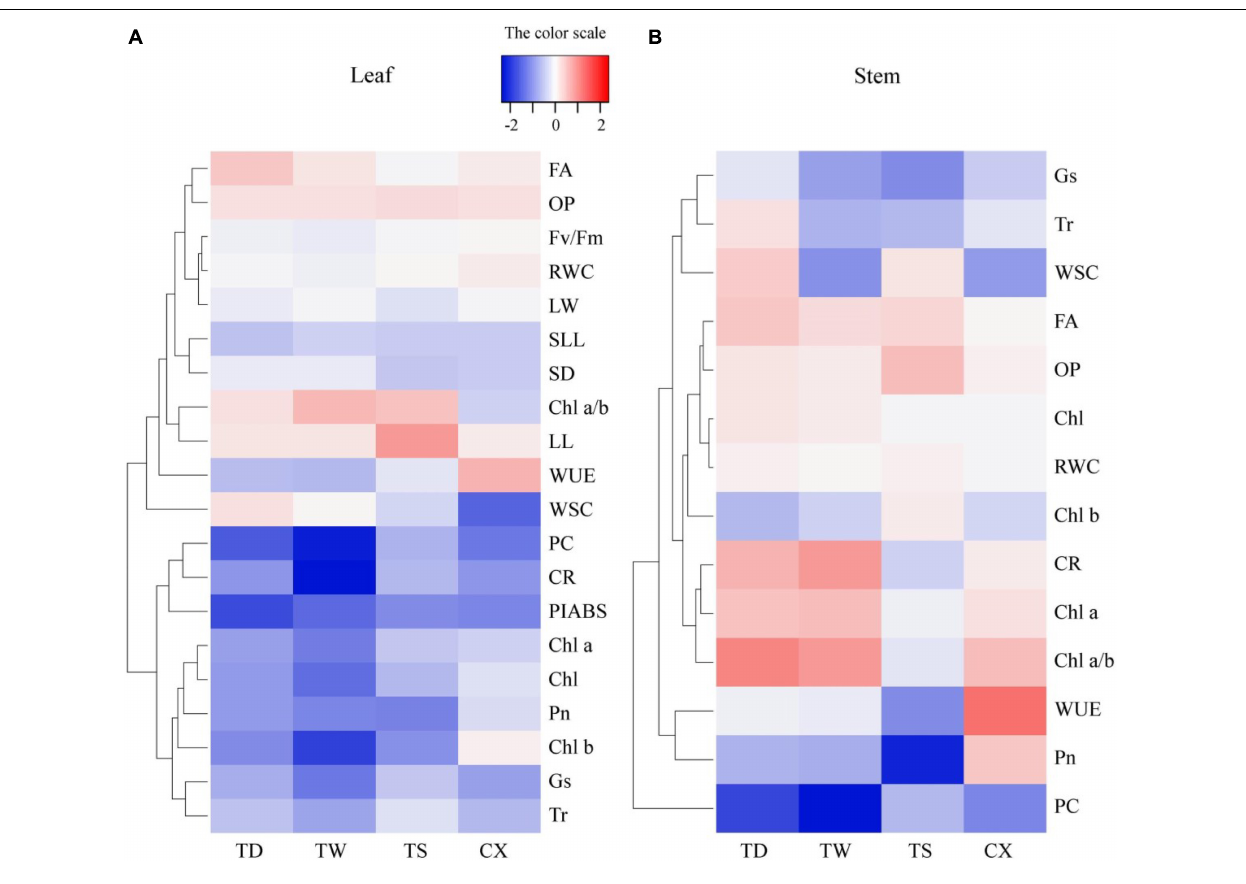
FIGURE 7 | Heatmap and hierarchical clustering for physiological and morphological parameters in (A) leaf and (B) stem of common and hybrid bermudagrasses.